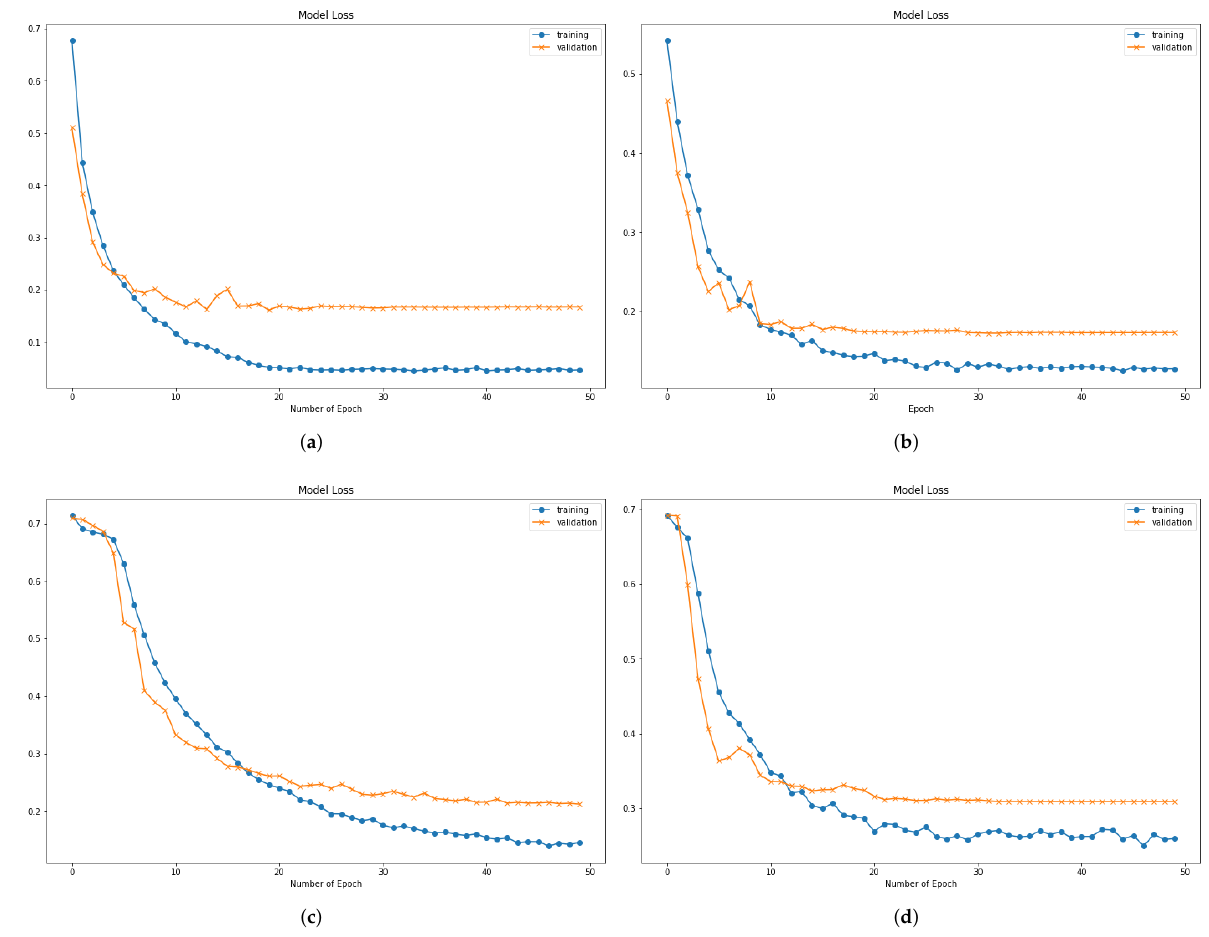
Figure 4. SD4A loss rate change on training and validation data ( a ) ; US-Airline loss rate change on training and validation data ( b ) ; Sentiment140 loss rate change on training and validation data ( c ) ; Sentiment140-MV loss rate change on training and validation data ( d )